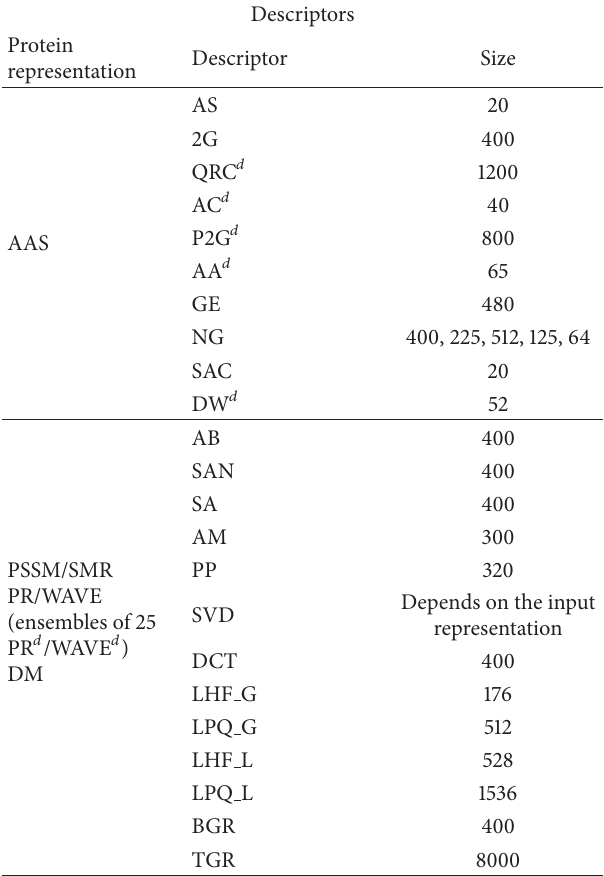
Table 2: Summary of the descriptors (short names are defined in Sections 3 and